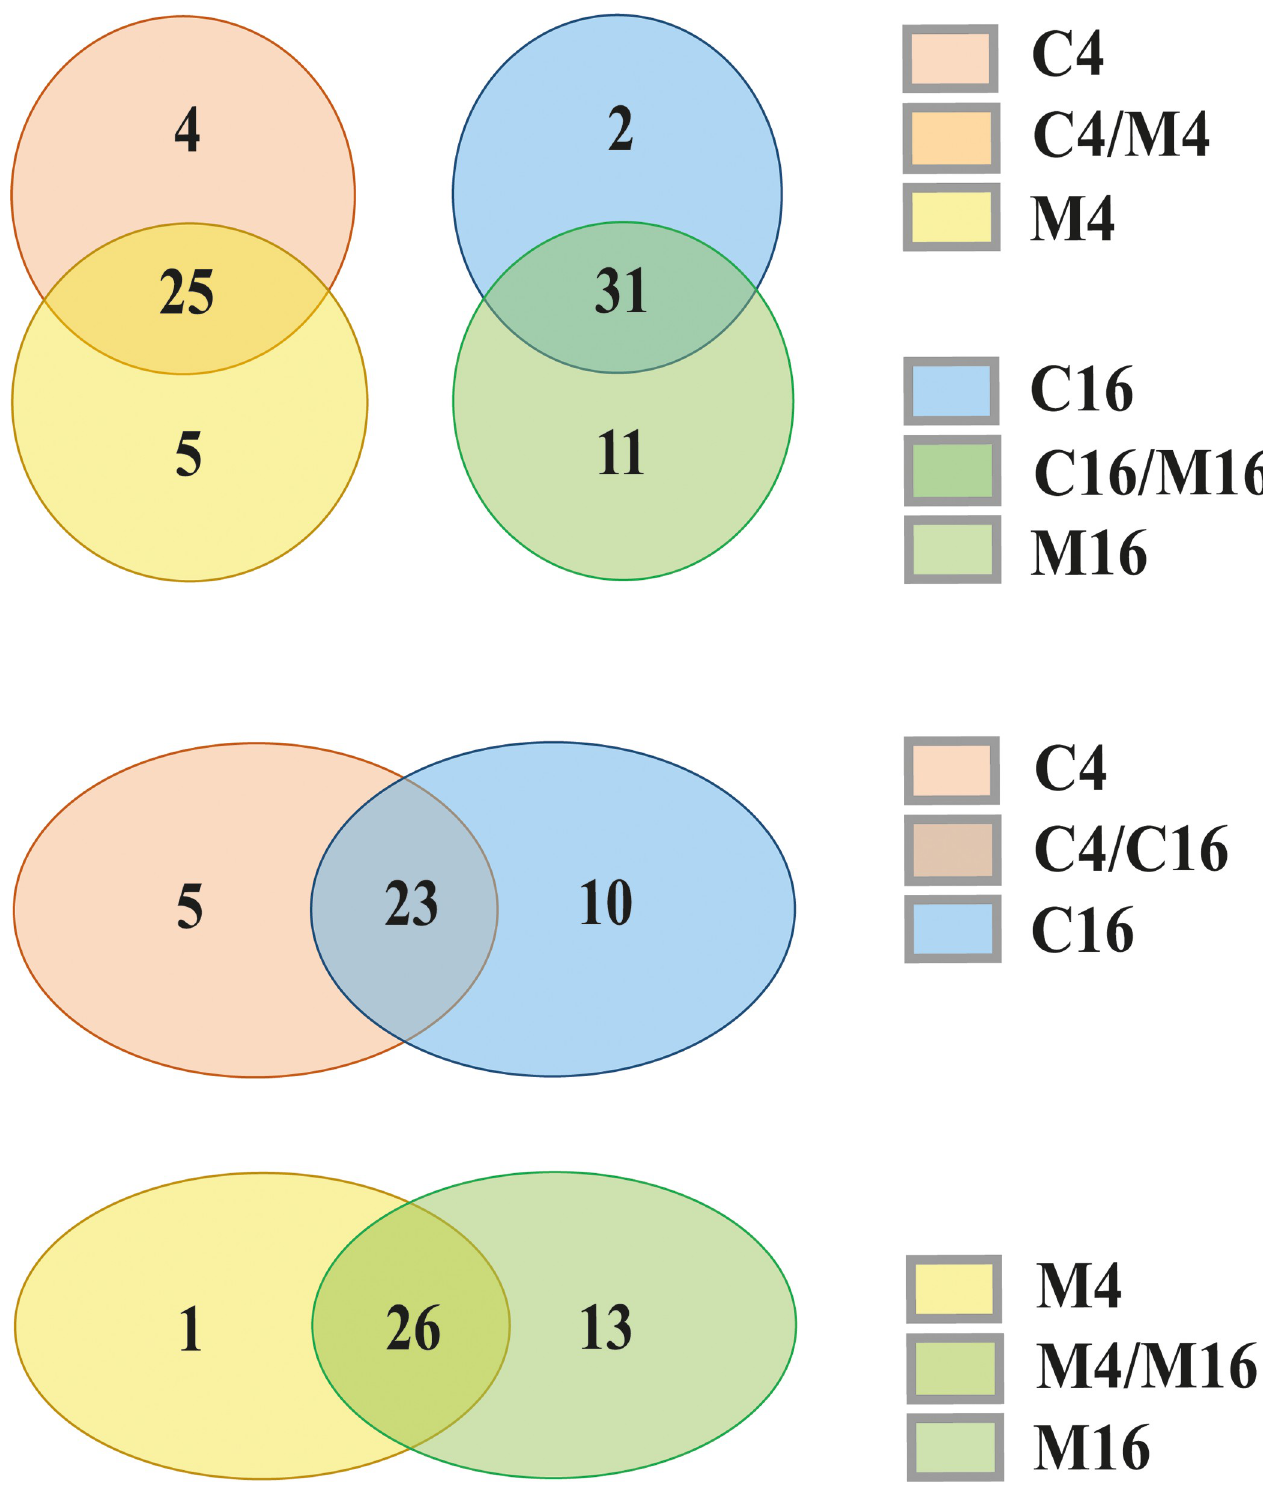
Fig 3. Number of expressed reverse transcriptase sequences (more than one mapped read × million in at least one library) in Helianthus annuus roots at 4 and 16 days after arbuscular mycorrhizal fungal inoculation (M: mycorrhizal roots; C: control roots).